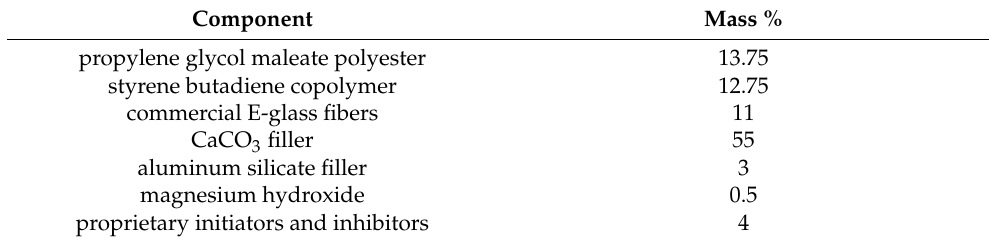
Table 1. GFRP-BMC components.